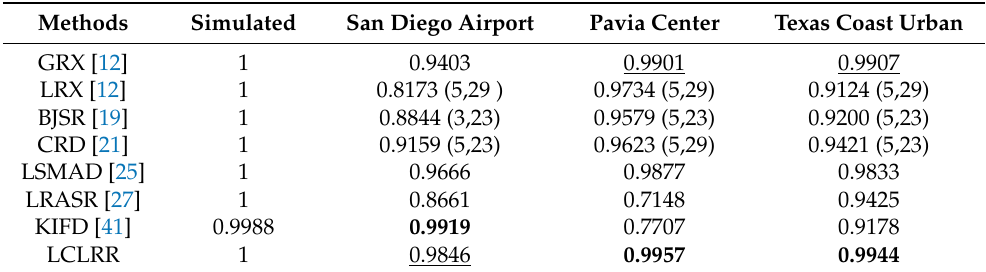
Table 1. The AUC values of different algorithms for four datasets including simulated, San Diego airport, Pavia center, and Texas Coast urban. The best results are in bold, and the second-best outcomes are